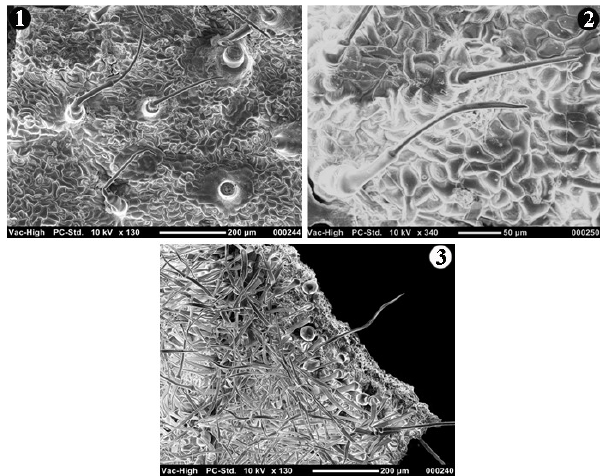
Fig. 4. Scanning electron micrographs (SEM) of trichomes of Inula species. 1. Non-glandular trichomes on stem of I.